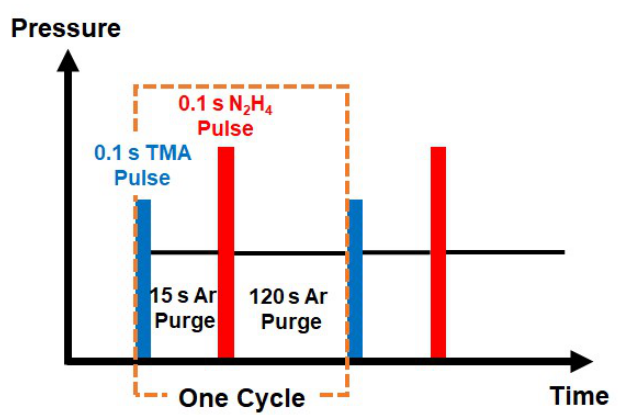
Figure 2. Schematic of atomic layer deposition (ALD) cycle for deposition of AlN using trimethylaluminum (TMA) and hydrazine (N 2 H 4 ). One cycle of the ALD process condition is: TMA pulse (0.1 s)–Ar purge (15 s)–N 2 H 4 pulse (0.1 s)–Ar purge (120 s).